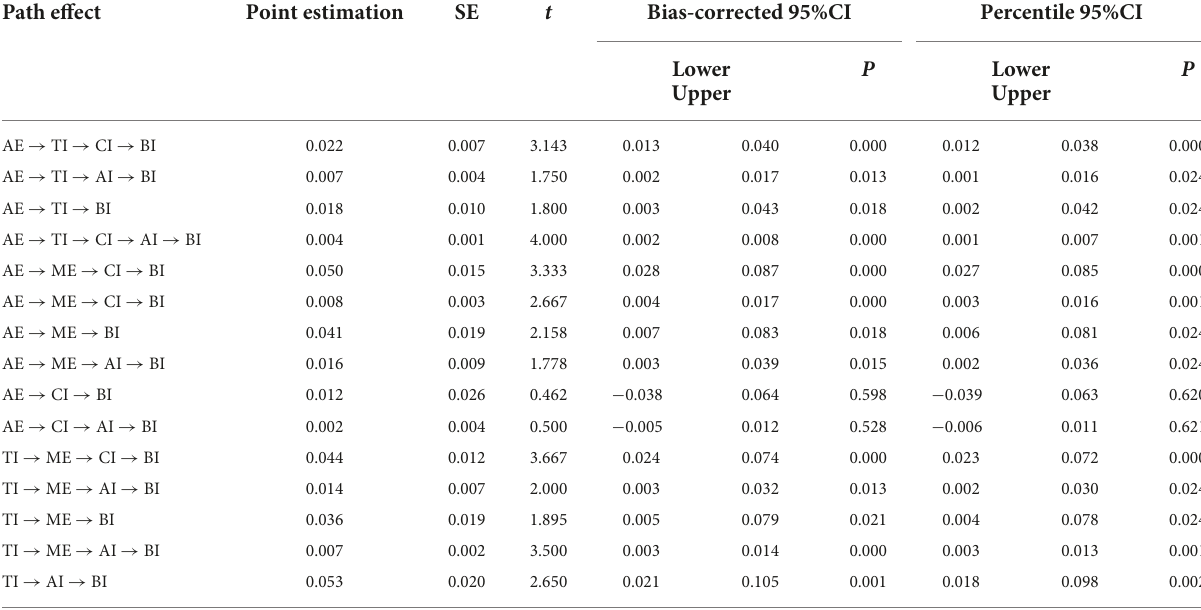
TABLE 7 Results of the mediating